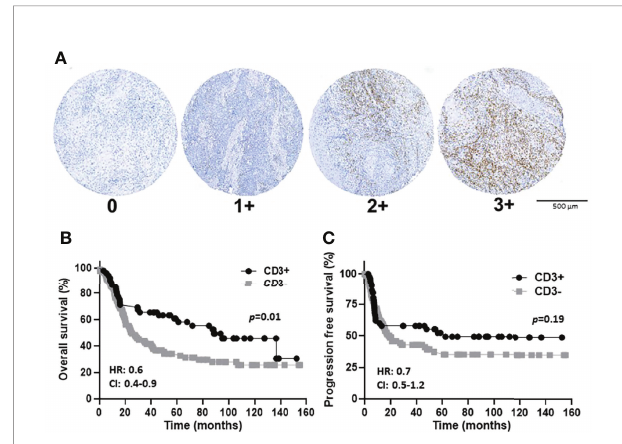
FIGURE 3 | EGFR immunostaining and expression scores in OSCCs. (A) : Shown are images of low [1+], moderate [2+], and strong [3+] EGFR expression scores. (B, C) : Shown are Kaplan-Meier estimates of the overall survival (B) and progression free survival (C) of EGFR+ (2+ and 3+) and EGFR- (0 and 1+) patients. HR, hazard ratio; CI, 95% con fi dence interval.